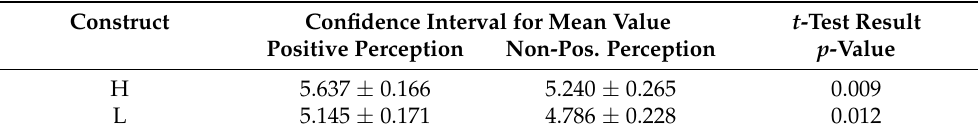
Table 3. Association between confidence in high-price (H) and low-price (L) signals as quality cue and organic wine